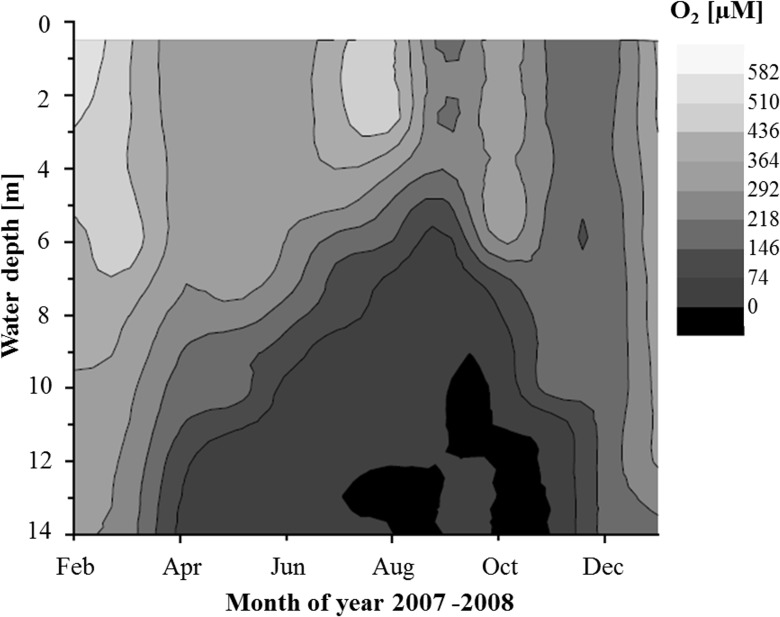
Oxygen concentrations in Lake Rotsee during an annual cycle (2007).Seasonal hypolimnic anoxia commenced in April and lasted until mid-November, when turnover occurred and the water column became fully mixed.